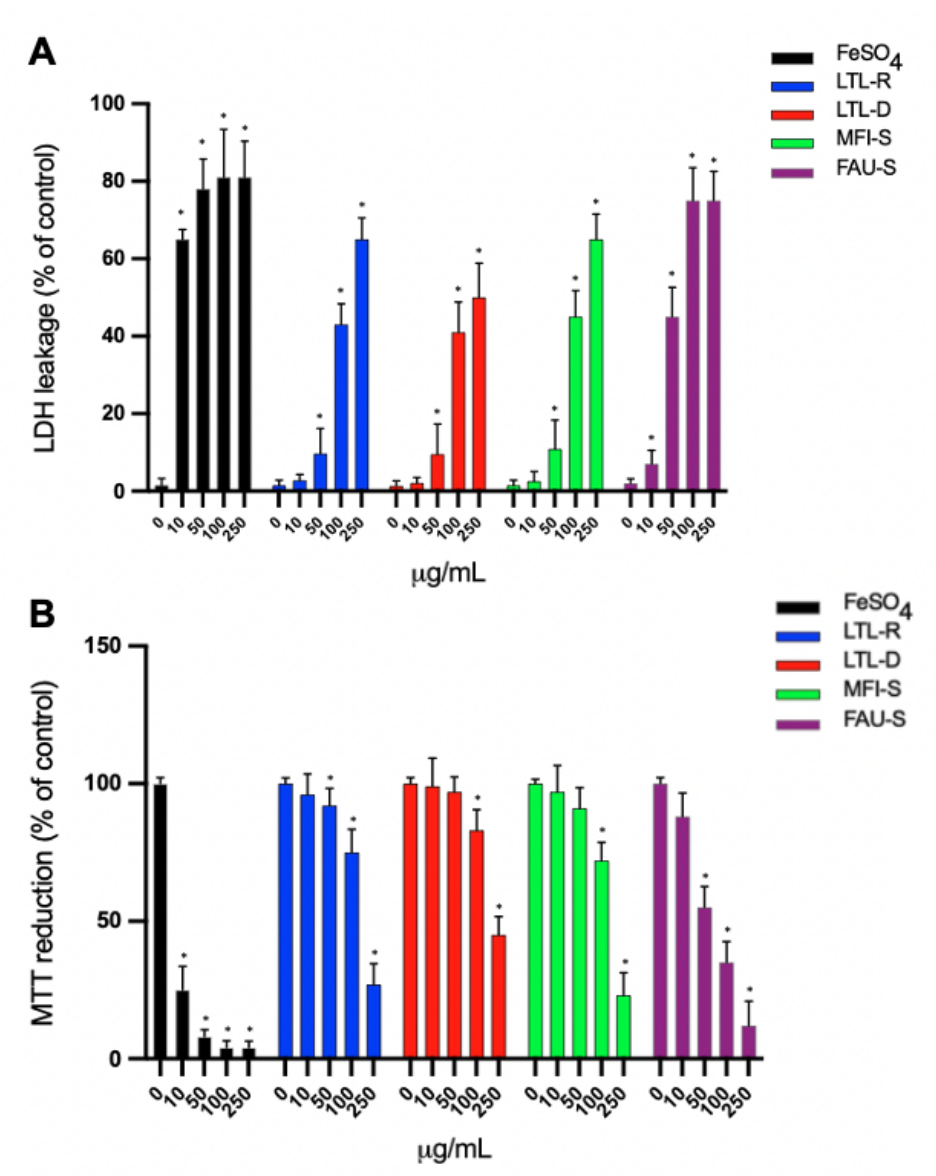
Figure 5. Cytotoxic effect of zeolites on lung fibroblast IMR-90 cells. Cells were treated with different concentration of zeolites for 72 h. ( A ) LDH leakage in medium. The percent of LDH activity was calculated by dividing the amount of acivity in the medium by the total activity (medium and cell lysate). Controls were cultured in zeolite free media were run in parallel to the treatment group. ( B ) Effect of zeolite on mitochondrial function determined by MTT reduction in IMR-90 human lung fibroblasts. The cells were incubated for 72 h with various concentrations (0, 10, 50, 100, 250 µ g/mL) of zeolite LTL-R, LTL-D, MFI-S and FAU-S. Ferrous sulfate (FeSO 4 ) was used as positive control. The results are presented as mean values ± SD versus unexposed cells to zeolites. The data are expressed as mean ± SD of three independent experiments. * indicates a statistically significant differences compared to